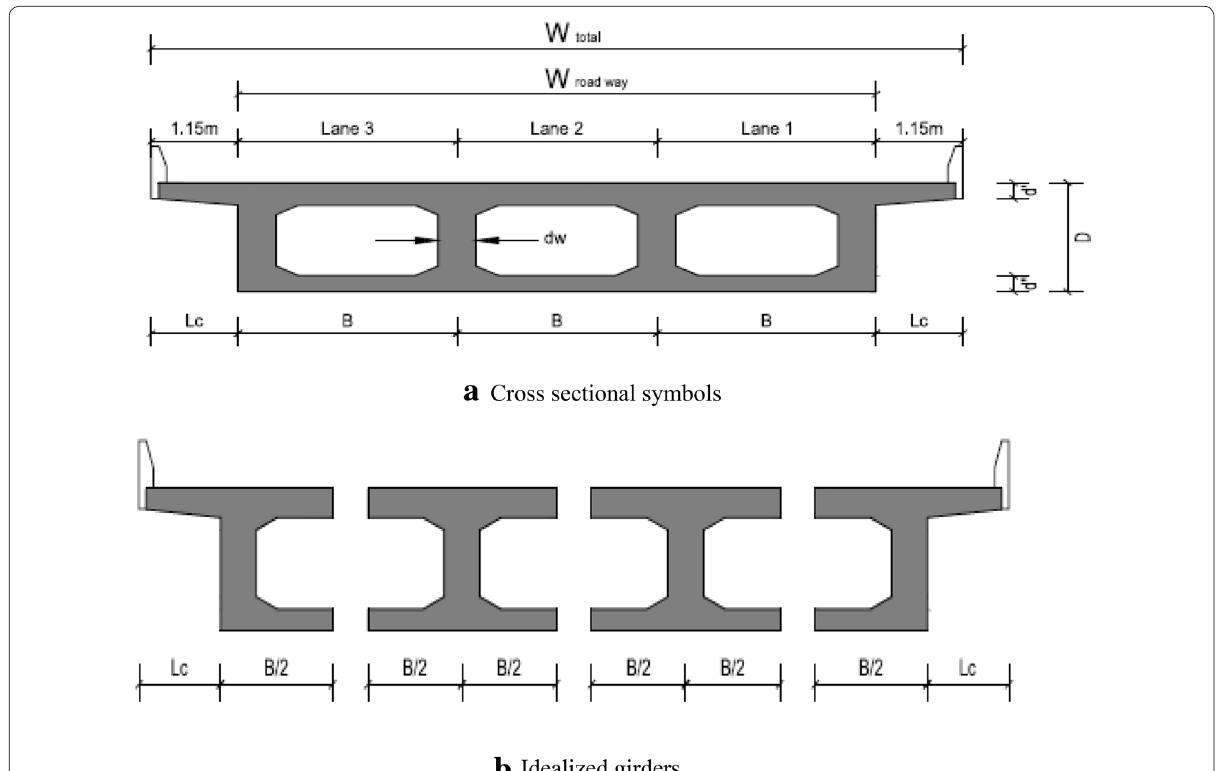
Fig. 1 Definitions of cross sectional symbols and idealized girders for MCB